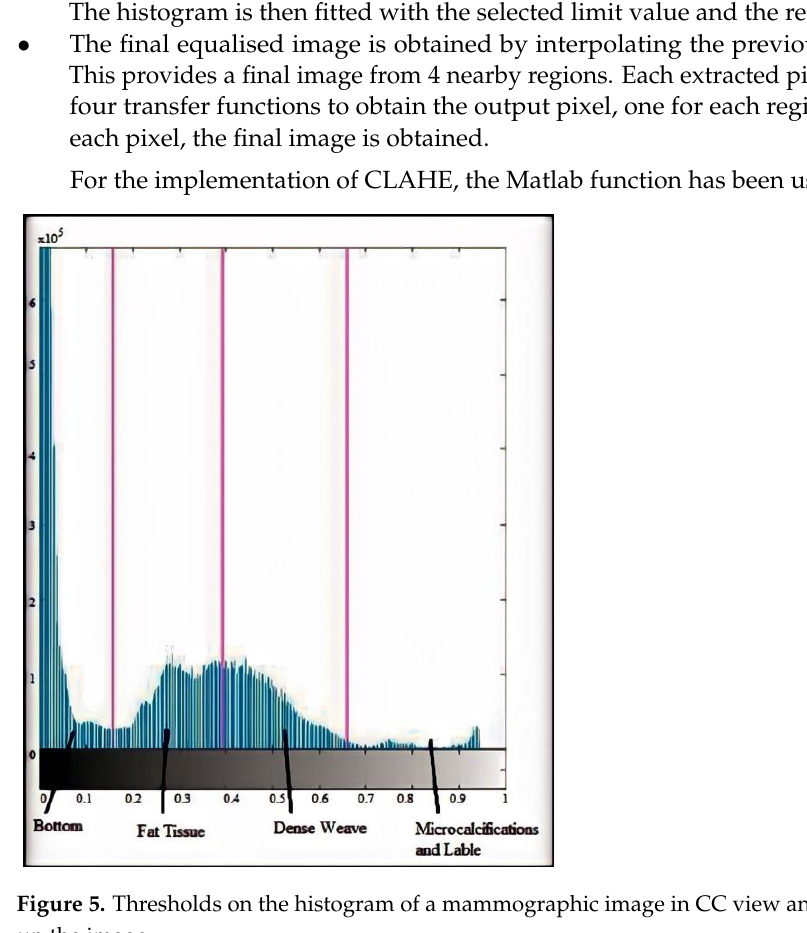
Figure 5. Thresholds on the histogram of a mammographic image in CC view and tissues that make up the image.